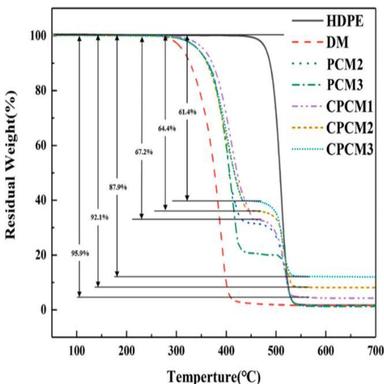
TGA curves of the HDPE, DM, PCM2–PCM3, and CPCM1–CPCM3.